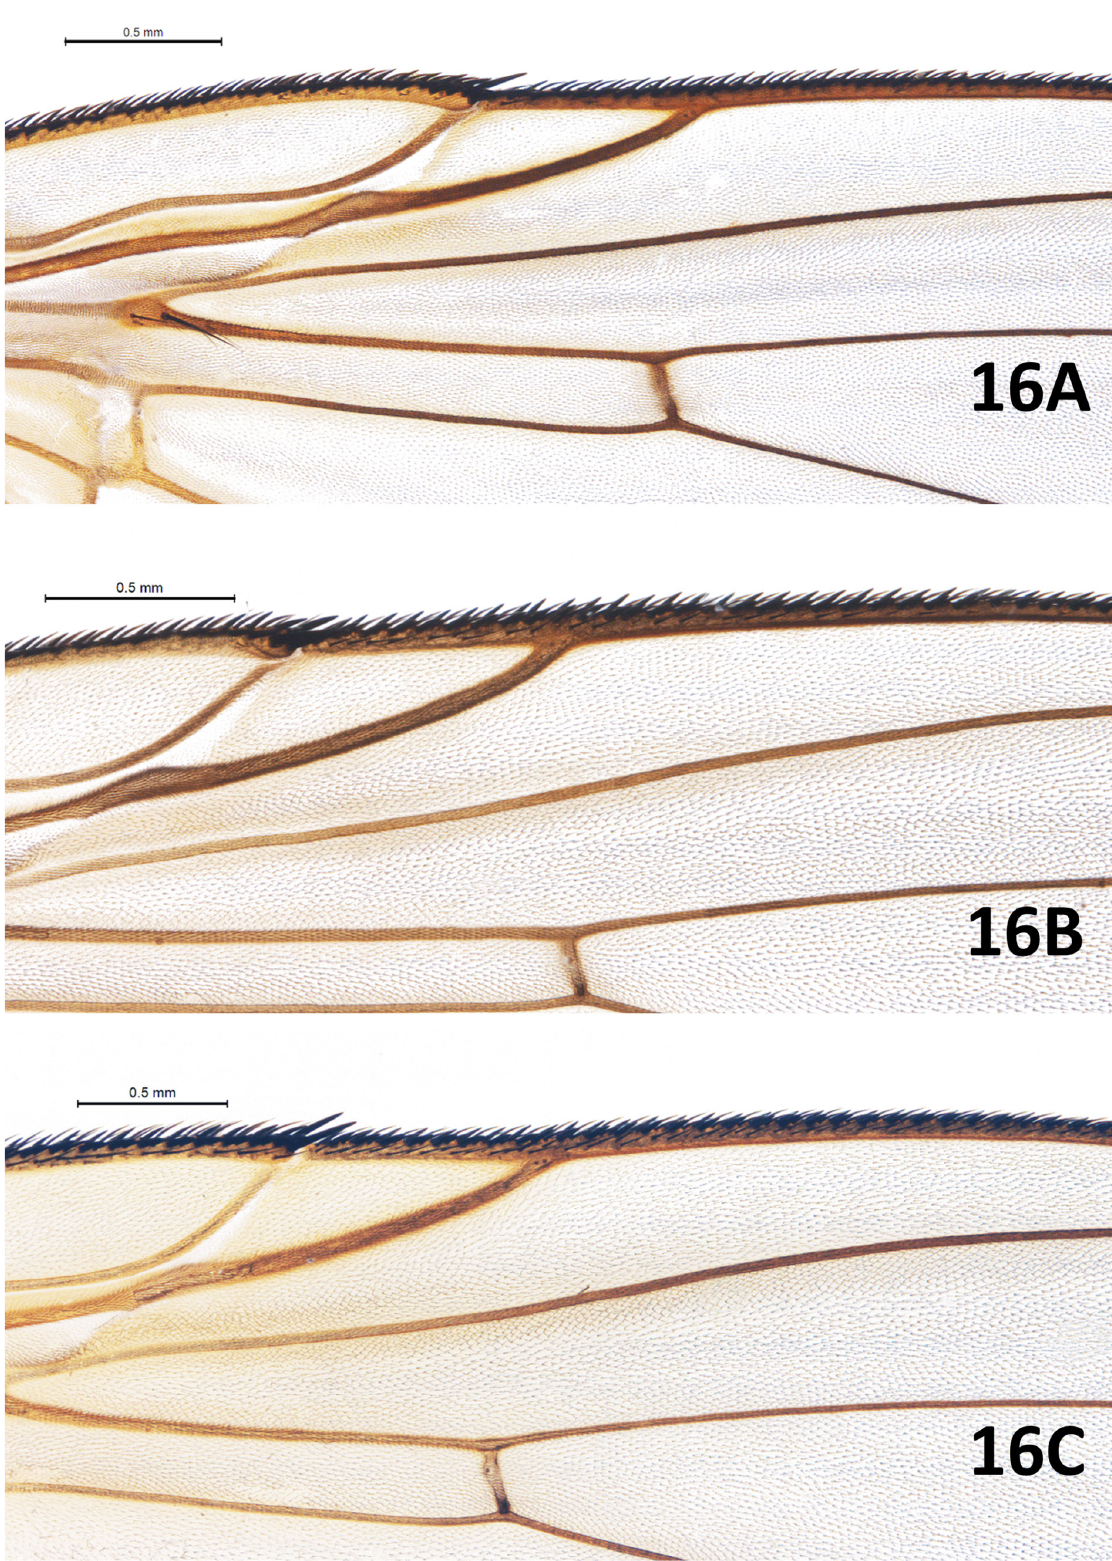
Fig. 16. ♀♀ of Muscidae Latreille, 1802. A . Hebecnema umbratica (Meigen, 1826), detail of wing showing CS1–3, dorsal view. B . H . nigricolor (Fallén, 1825), detail of wing showing CS1–3, dorsal view. C . Gymnodia subtilis (Stein, 1909), detail of wing showing CS1–3, ventral